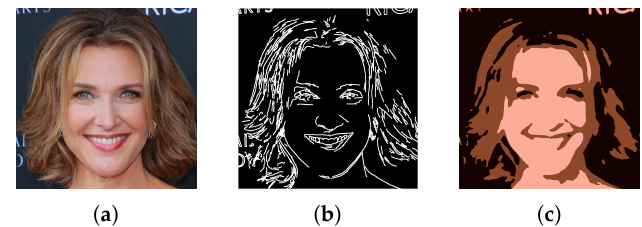
Figure 2. An example of the ground truth image and corresponding edge and color maps. ( a ) ground truth I gt ; ( b ) edge map E gt ; ( c ) color map C gt